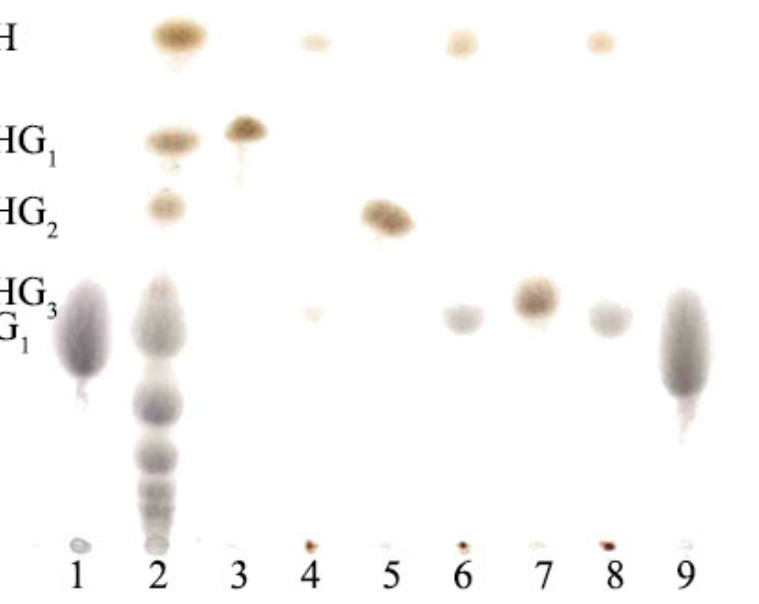
Figure 2. TLC analysis of glucoamylase treatment of hesperidin glycosides (HGs). Lanes 1, 9 standard glucose (G 1 ); Lane 2, a mixture of products from CGTase reaction for the synthesis of HGs; Lanes 3, 5, and 7, hesperidin glucoside (HG 1 ), hesperidin maltoside (HG 2 ) and hesperidin maltotrioside (HG 3 ), respectively; Lanes 4, 6, and 8, HG 1 , HG 2 and HG 3 with glucoamylase treatment; H,